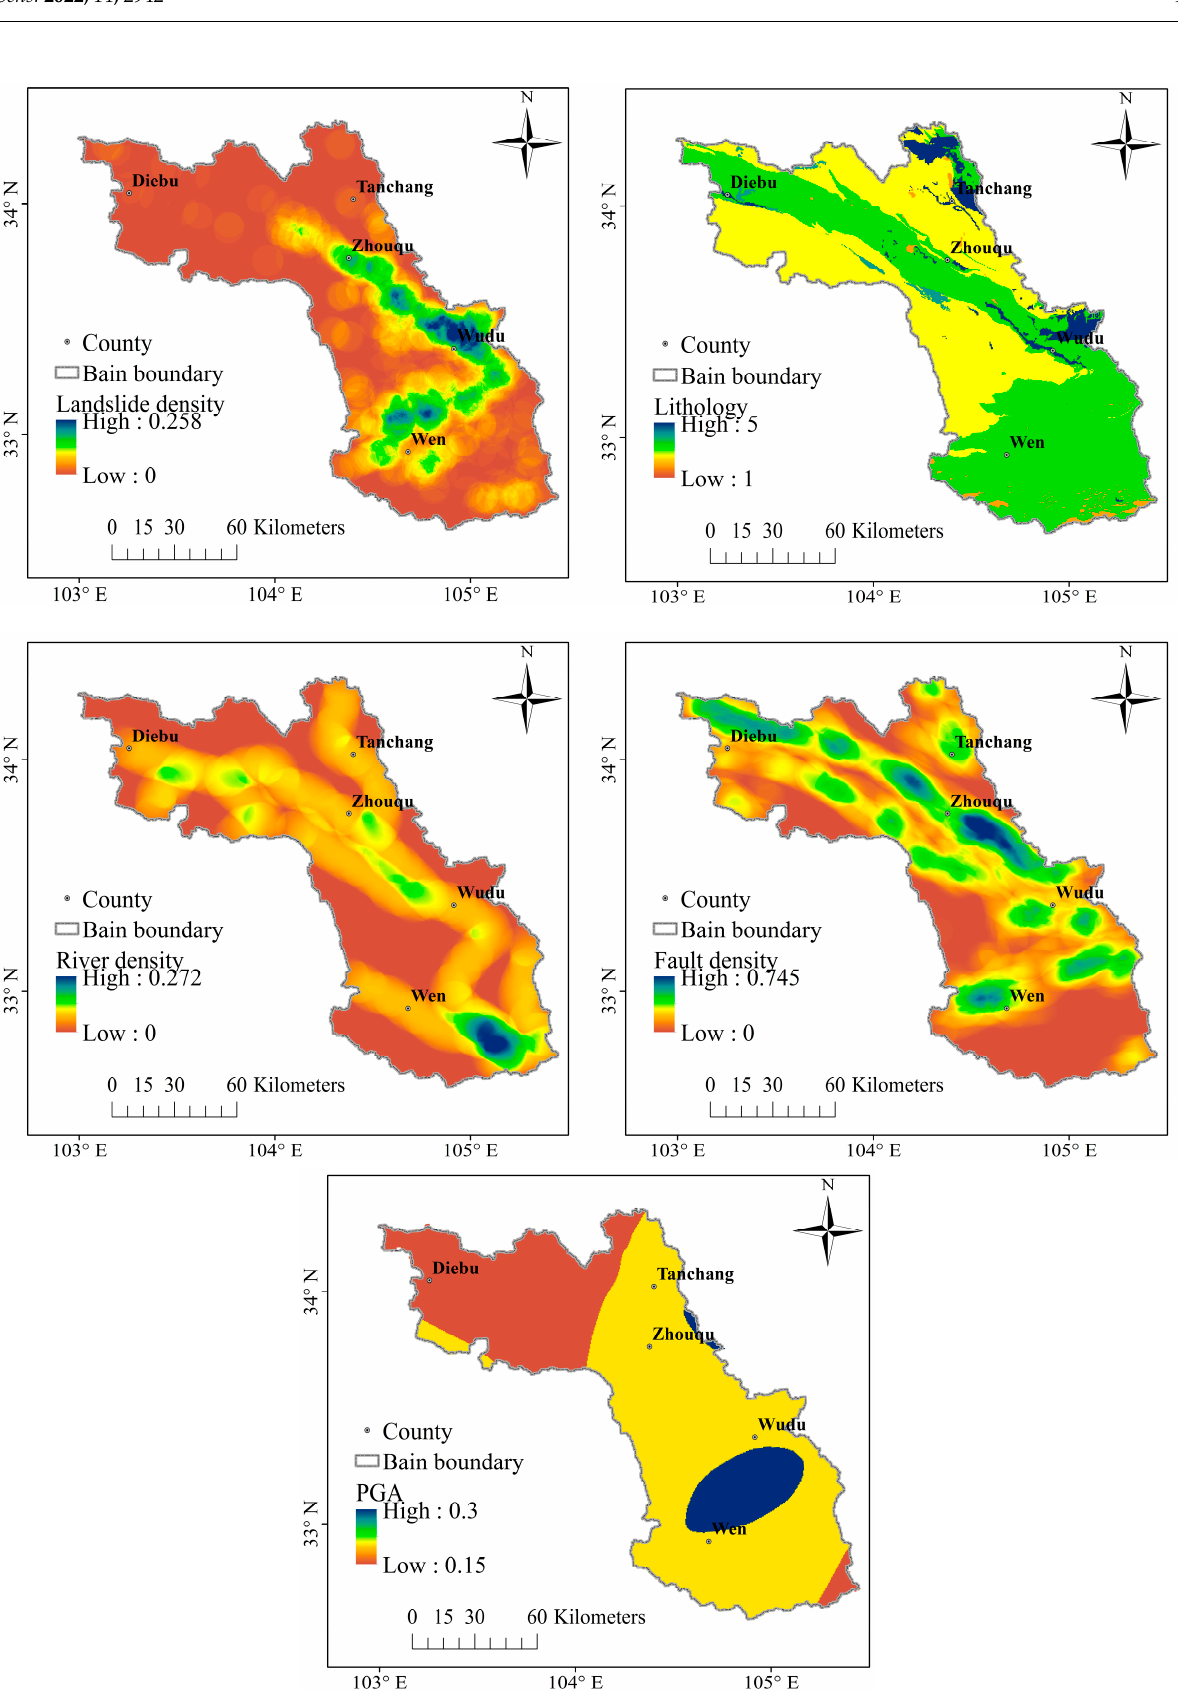
Figure 4. Distribution of factors related to geological structure.